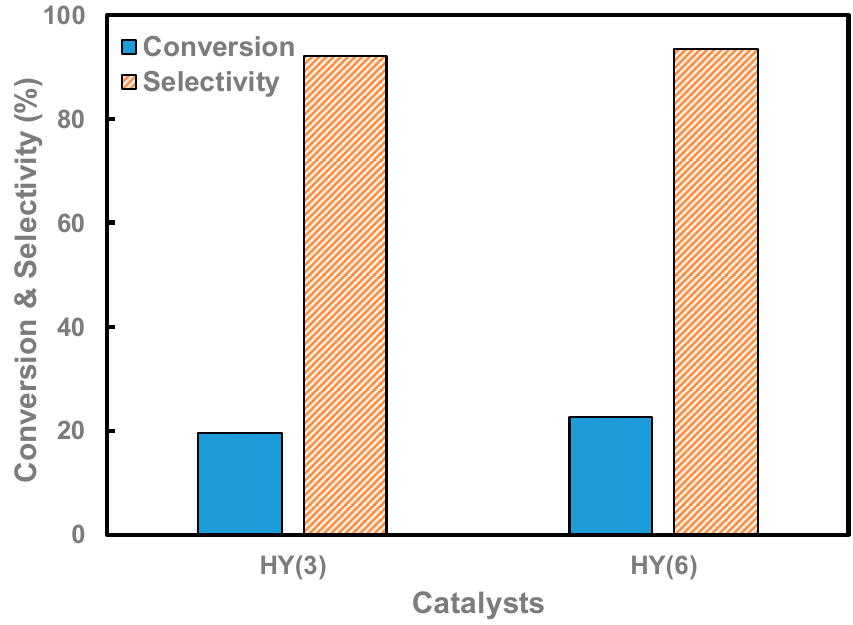
Figure 8. Conversion of TEC and selectivity of ATEC in the acetylation over HY zeolites of 1 h reaction time.